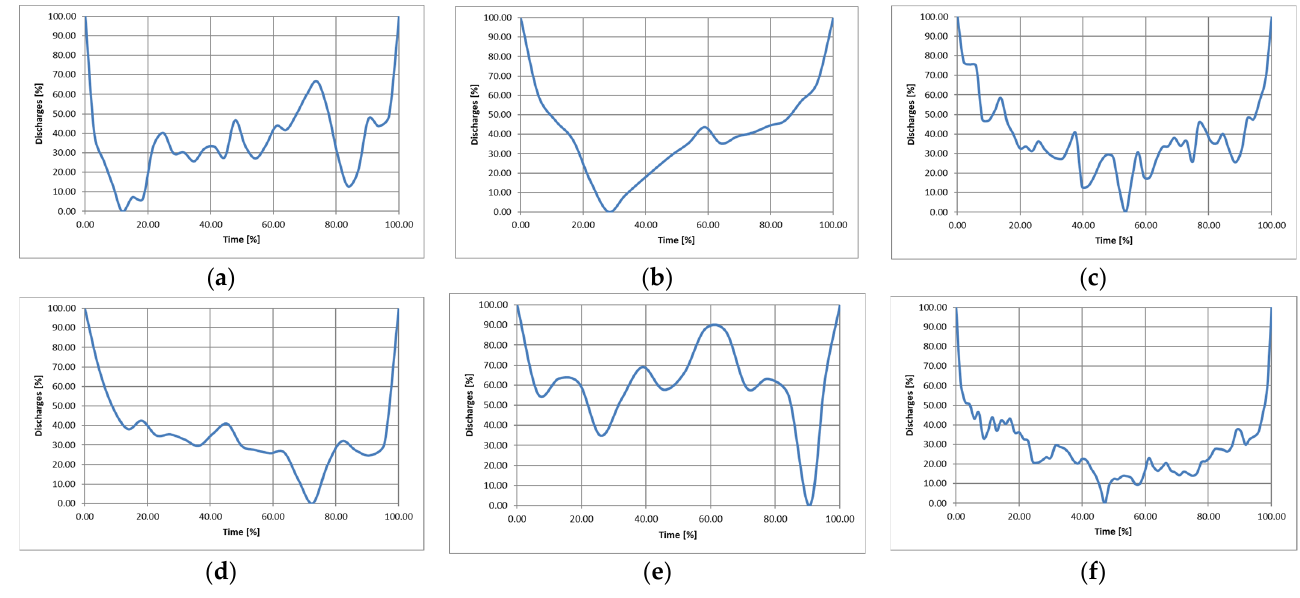
Figure 8. Shape of dimensionless droughts: ( a ) Class 1; ( b ) Class 2; ( c ) Class 3; ( d ) Class 4; ( e ) Class 5; ( f ) Class 6.